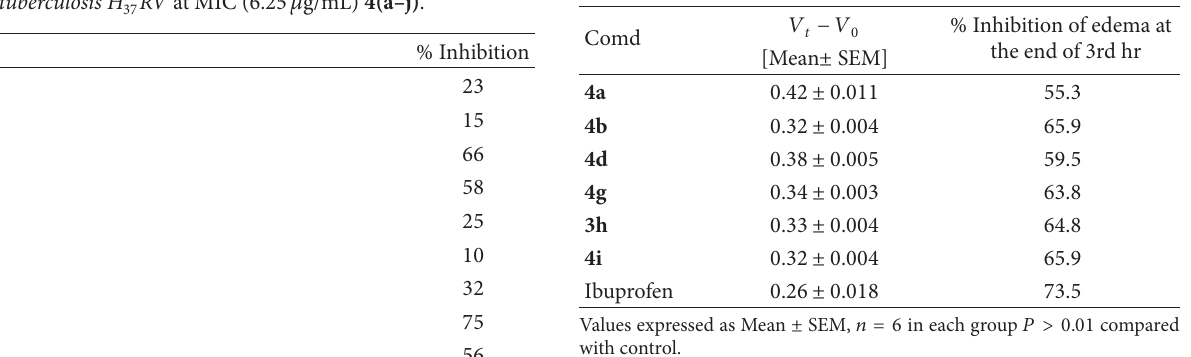
T 2: Percentage inhibition of compounds against Mycobac- T 3: In vivo anti-in�ammatory activities of Schiff